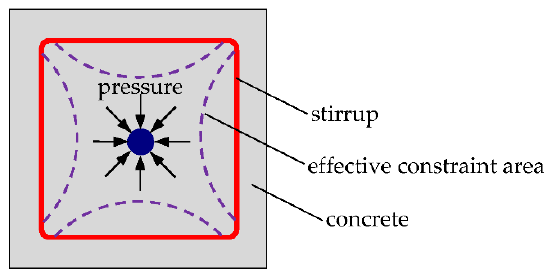
Figure 8. Schematic diagram of stirrup confinement.